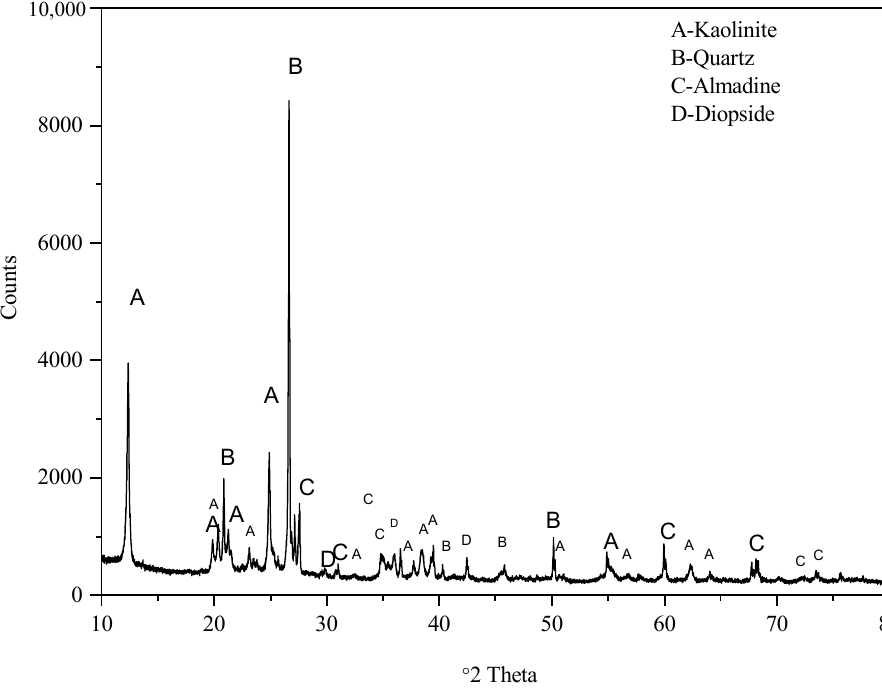
Figure 2. X-ray diffractograms of the coal gangue considered in this study for identification of various peaks of clay minerals. Initially, six specimens of each were prepared for the control samples cured at 1,7,14, and 28 days, respectively. The percentage of lime dosage varied between 0 and 6%. Hence, the number of samples prepared at this point was 96. Subsequently, the mix was continued similarly except the gypsum dosage was changed from 0 to 0.5, 1, and 1.5% (Table 3), thus yielding total of 384 samples. Table 3. Details of the input and target variables as well as the database used in ANN and RF modelling.